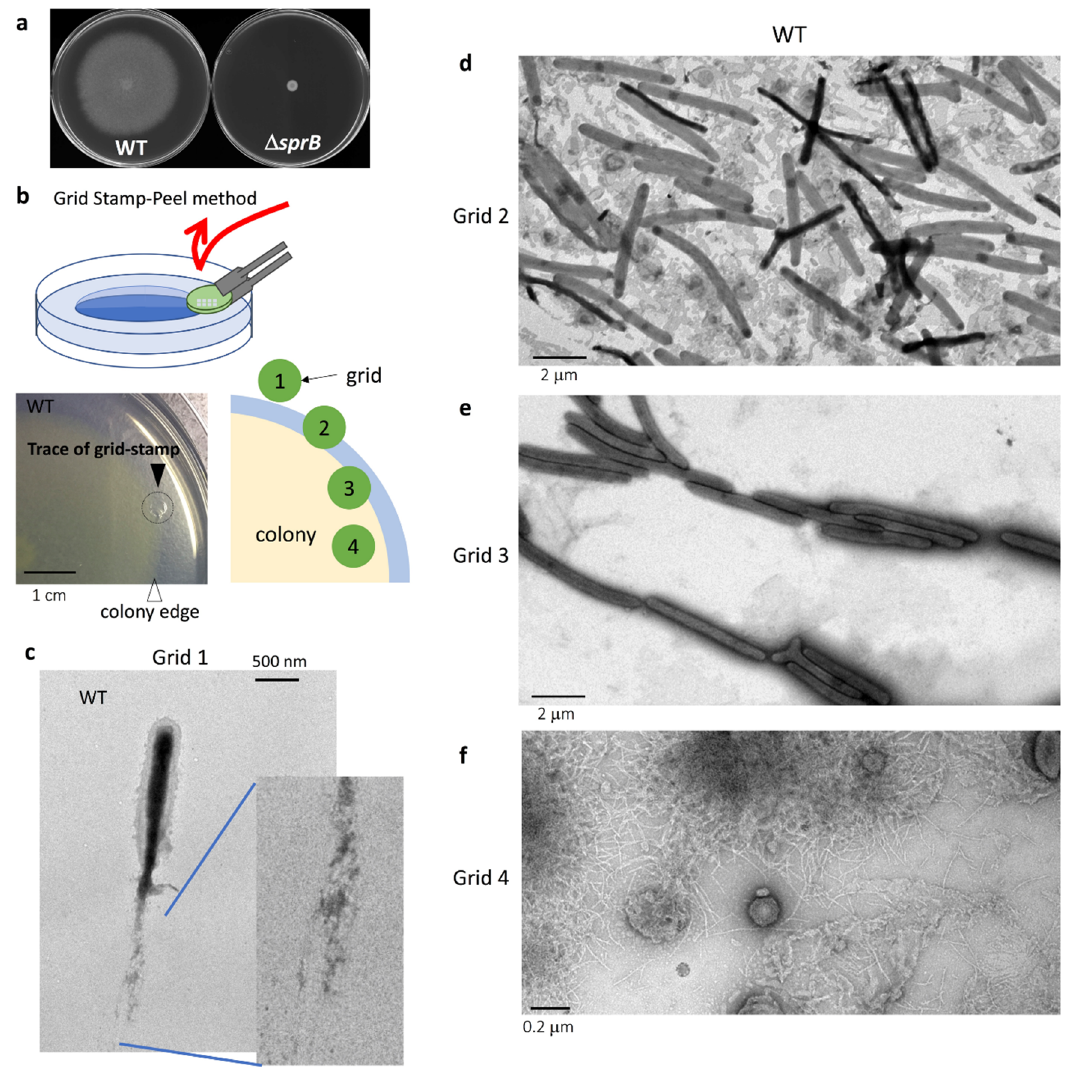
Figure 1. Grid Stamp-Peel peel method and the resulting TEM images of the top surface above the leading tip of a WT F. johnsoniae colony. The colony was formed on 1% A-PY2. ( a ) Colony spreading of F. johnsoniae on 1% agar-PY2 (peptone-yeast extract) medium (1%A-PY2) in a 9 cm diameter dish (5 days). Left panel, WT; right panel, sprB . ( b ) The Grid Stamp-Peel method (grid stamp method). Top panel: Schematic showing a colony being ‘stamped’ by a thin-carbon TEM grid. The surface layer of the colony is transferred to the carbon grid by pressing (stamping) the grid onto it. In practice, the weight of the grid provides sufficient pressure. Bottom panels: Expanding colony sampled by the grid stamp method (left) and a schematic indicating the stamping procedure (right). The F. johnsoniae colony has a yellow body and a surrounding translucent fringe as the leading edge. These are colored yellow and blue, respectively, in the diagram. Green circles indicate the position of each grid stamp (Grids 1 to 4). ( c – f ) TEM of grid stamps 1–4 stained with uranyl acetate. The structure of the colony surface varied, depending on the region sampled. ( c ) A single F. johnsoniae cell outside the extending translucent colony tip on the agar surface (position of Grid 1). Inset: enlargement (3×) of the indicated area. The leading cells laid a path of filaments. ( d ) Cells at a leading translucent fringe of the colony (position of Grid 2). Cells were interspersed among many small vesicles. ( e ) Cells immediately inside the edge of the colony (position of Grid 3). Cells made head-to-tail and/or side-to-side contact. ( f ) Images of the more proximal surface, 2 mm inside the yellow edge of the colony body (position of Grid 4). The surface was occupied by a substance containing extracellular fibers and vesicles. No cells were found.